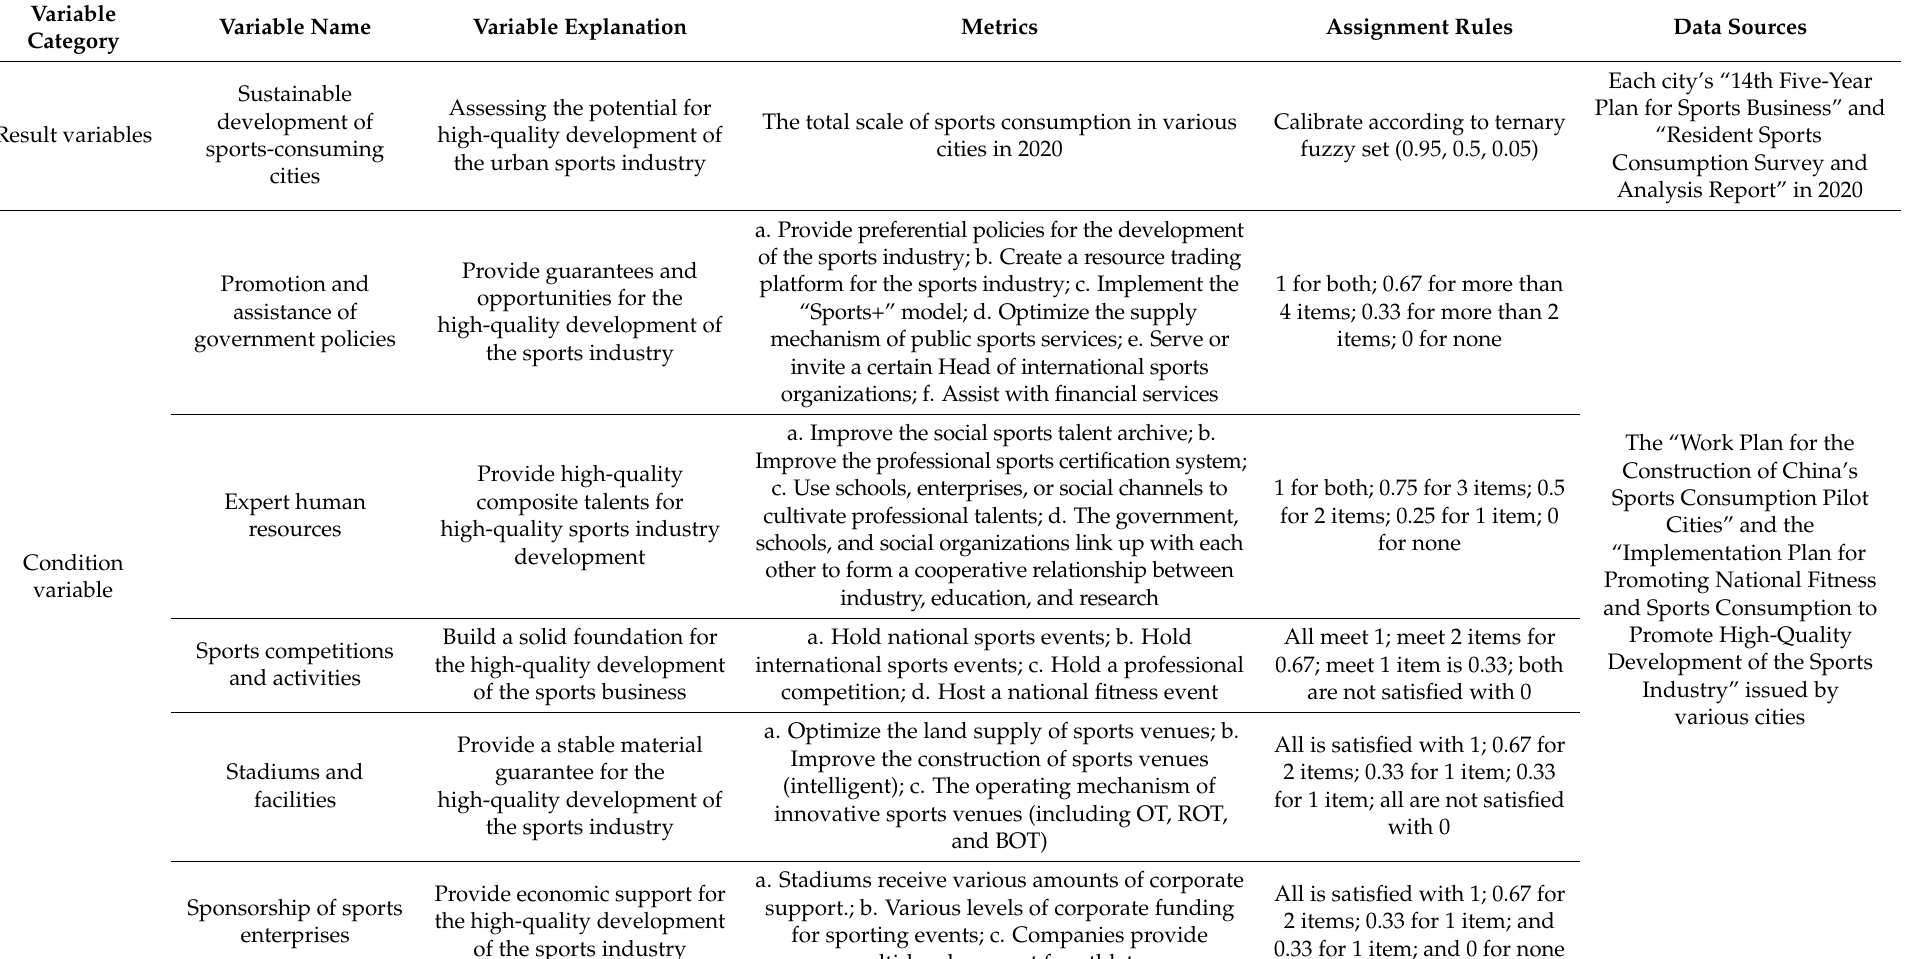
Table 1. Sustainable growth of sports-consuming cities: Variable interpretation, assignment guidelines, and data